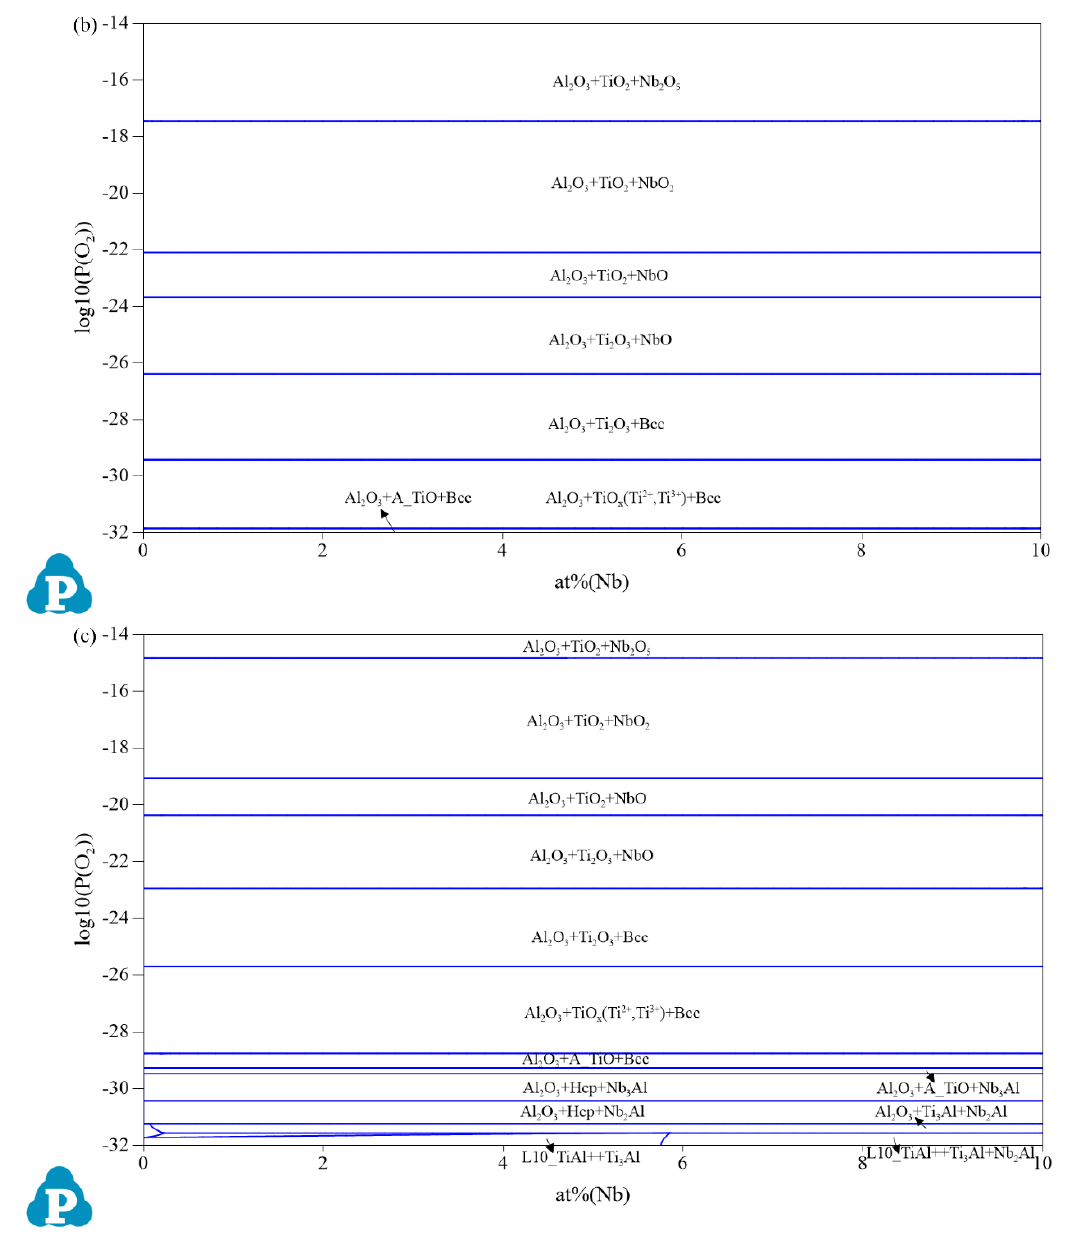
Figure 1. Initial oxidation products of Ti-42Al-xNb alloy at 700 °C ( a ), 800 °C ( b ), and 900 °C ( c ).